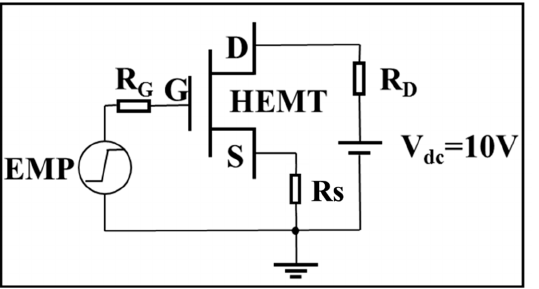
Figure 14. The simulation circuit with an external resistance R G at the gate, R D at the drain and R S at the